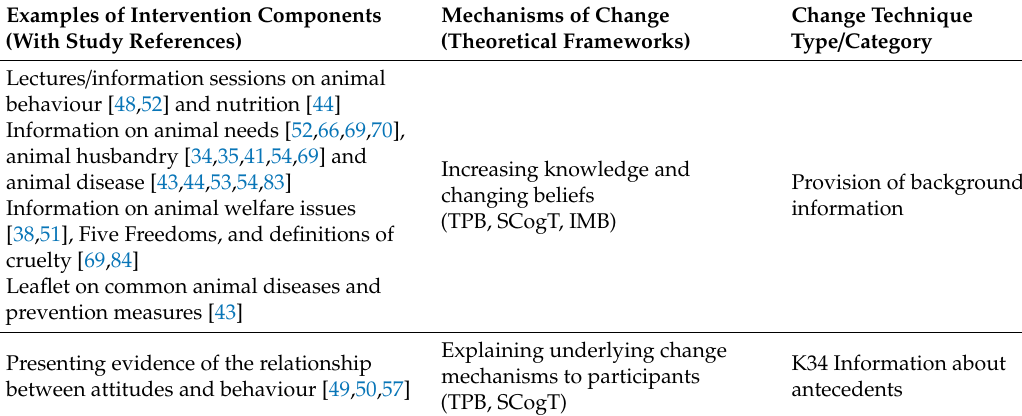
Table 2. Examples and classification of change techniques identified in 47 behaviour change interventions targeting animal care or interactive behaviours, mapped to mechanisms of change and theoretical